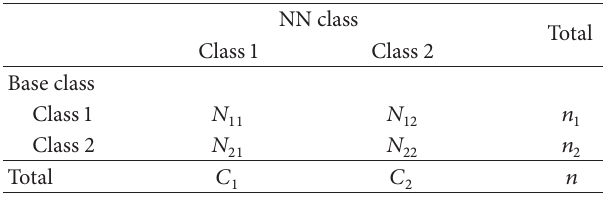
Table 1: The NNCT for two